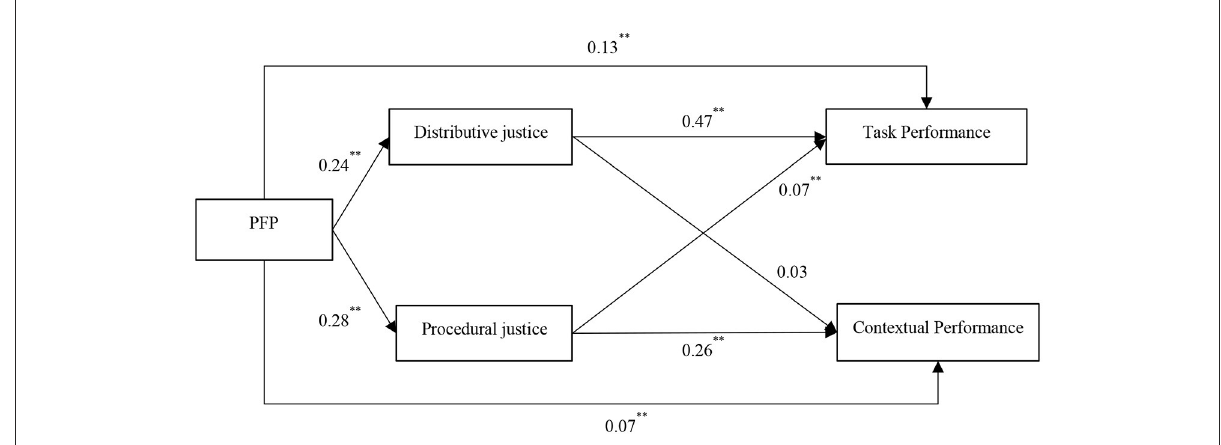
FIGURE3 Structural equation modeling results with justice. Coefficients presented were unstandardized estimates. Harmonic N = 4,401, * p < 0.05, ** p <